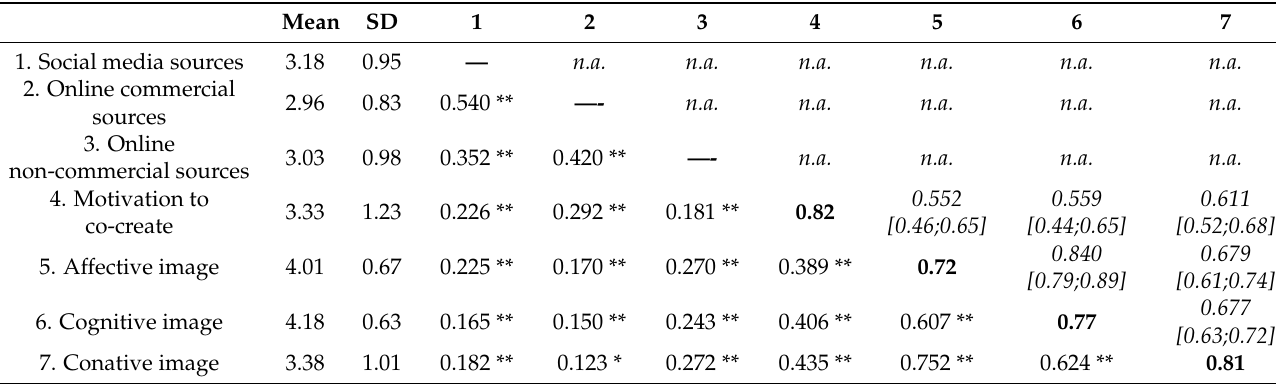
Table 4. Descriptive statistics, correlation matrix and square roots of AVE for the reflective constructs.